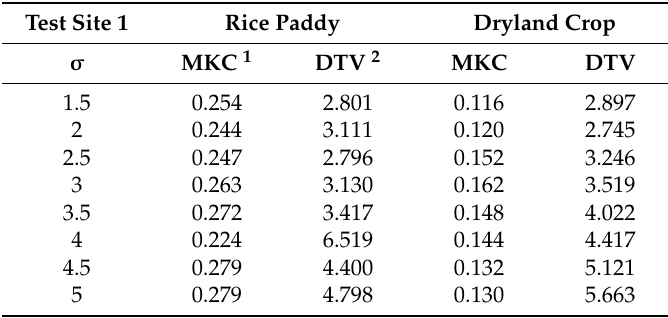
Table 5. Maximum kappa coefficient and the corresponding OLWDTW distance under different enhance factor σ values in test site 1.